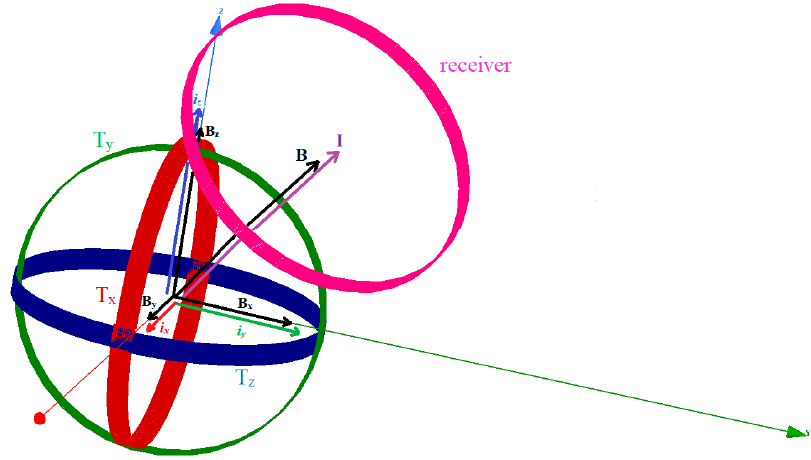
Figure 1. The 3D WPT system magnetic and electric resultant vectors.